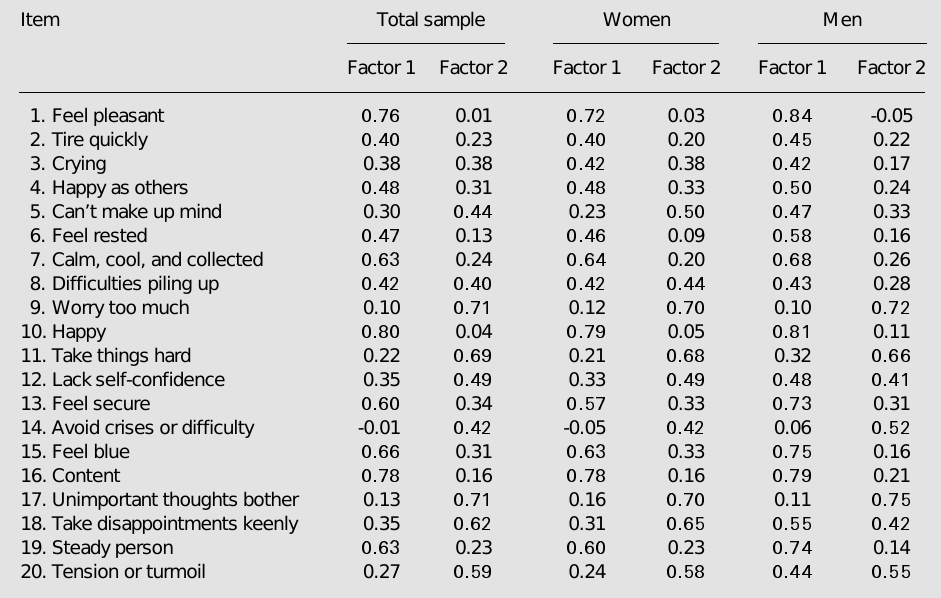
Table 3 - State-Trait Anxiety Inventory (trait form) item factor loadings after varimax rotation for the total sample and according to sex. Only loadings above 0.40 (bold) were considered to significantly contribute to a